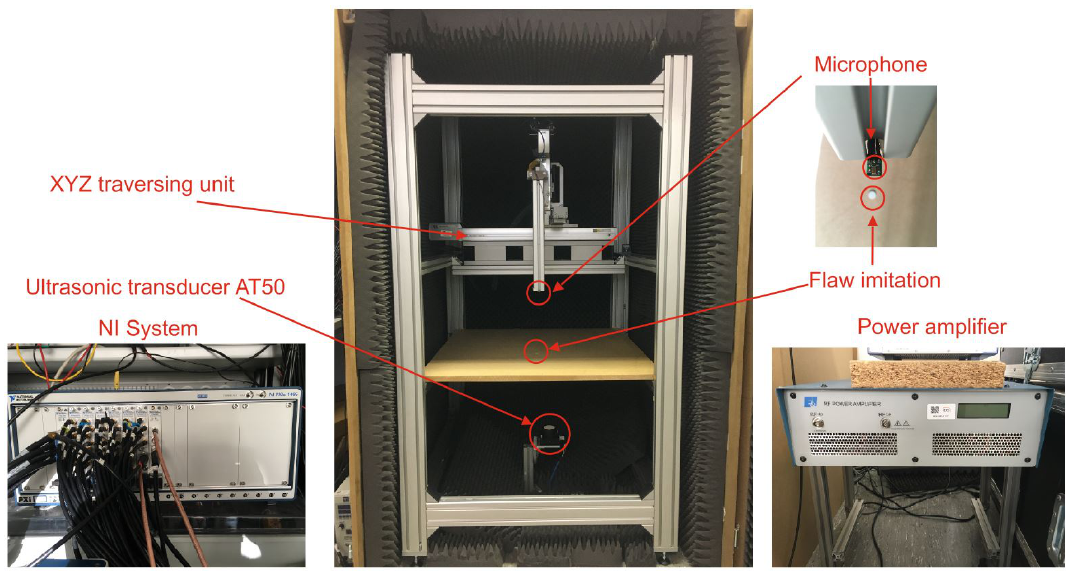
Figure 3. Experimental setup with a flaw imitation at the top of the wooden particleboard. NI = National